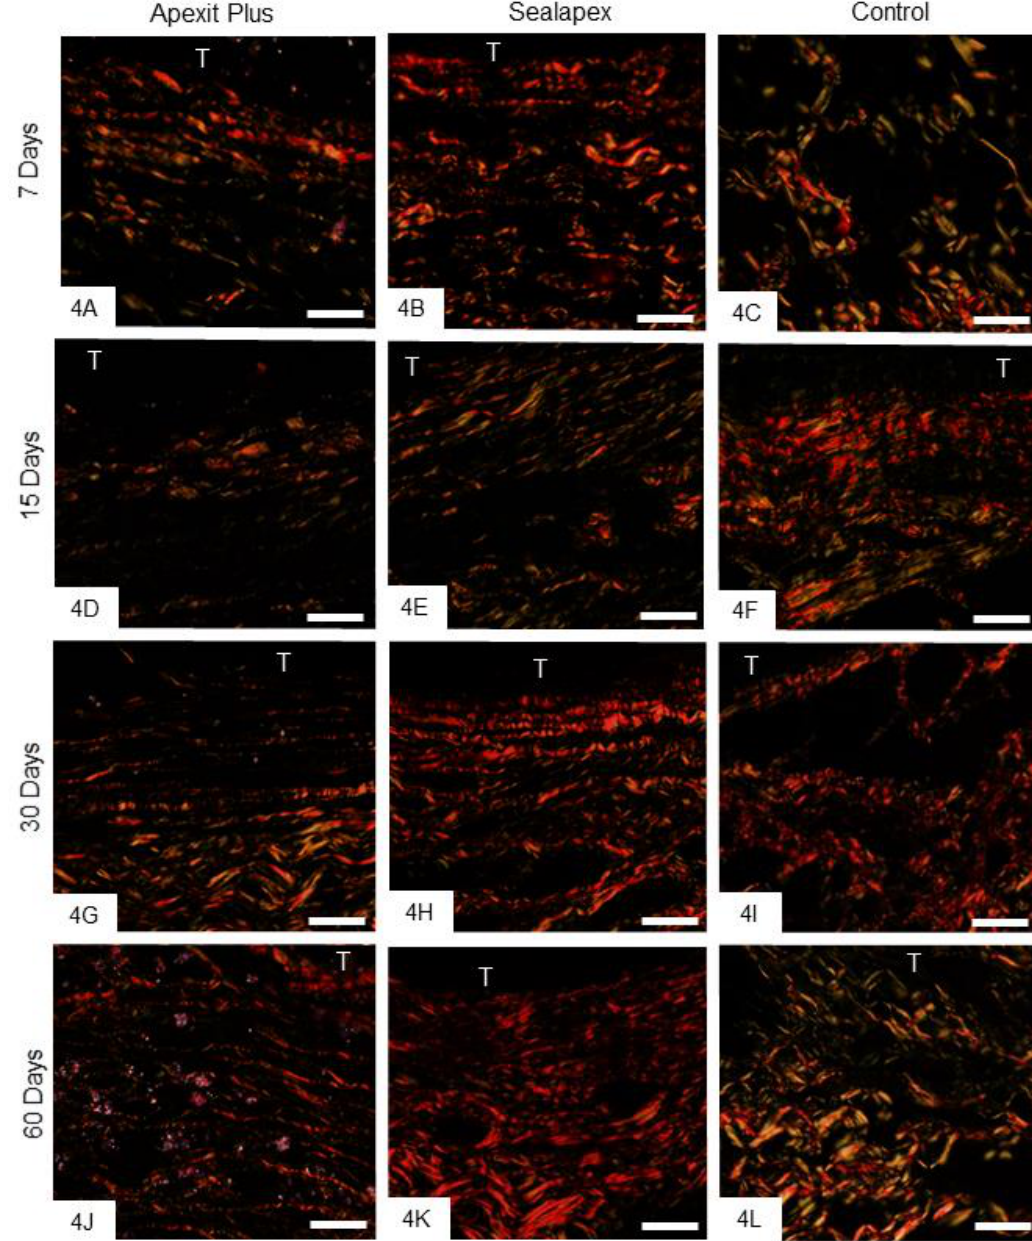
Figure 4. Photomicrographs show sections subjected to the Picro Sirius red and analyzed under polarized light. At 7 (4 A – C ) and 15 (4 D – F ) days, the capsules contain little birefringent material (orange, red, yellow). At 30 (4 G – I ) and 60 (4 J – L ) days, an evident increase in the amount of birefringent material is seen in the capsules. T, tube opening. Bars: 25 µm.